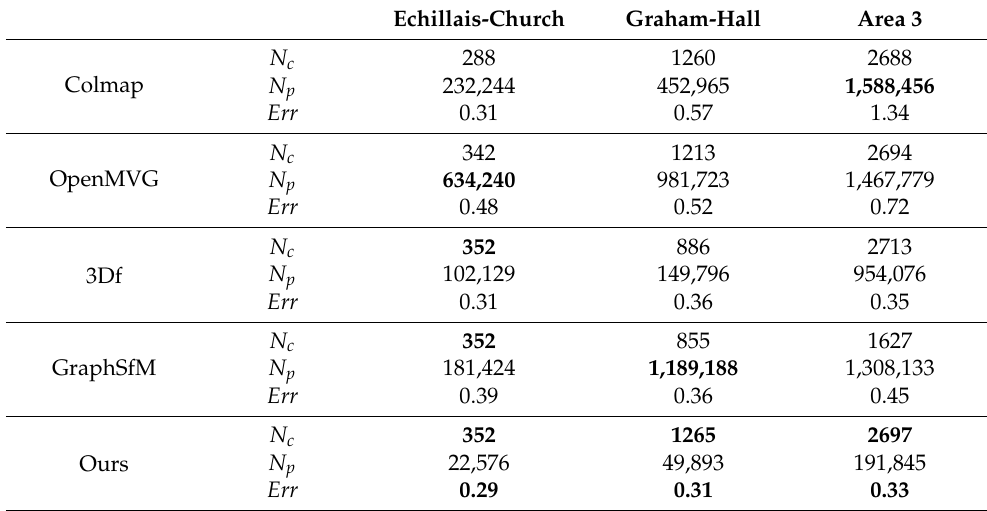
Figure 7. Subcluster merging results. Table 4. Subcluster merge precision statistics. ( N c : number of registered images; N p : number of structure points; 𝐸𝑟𝑟 : reprojection error (MSE), in pixels).